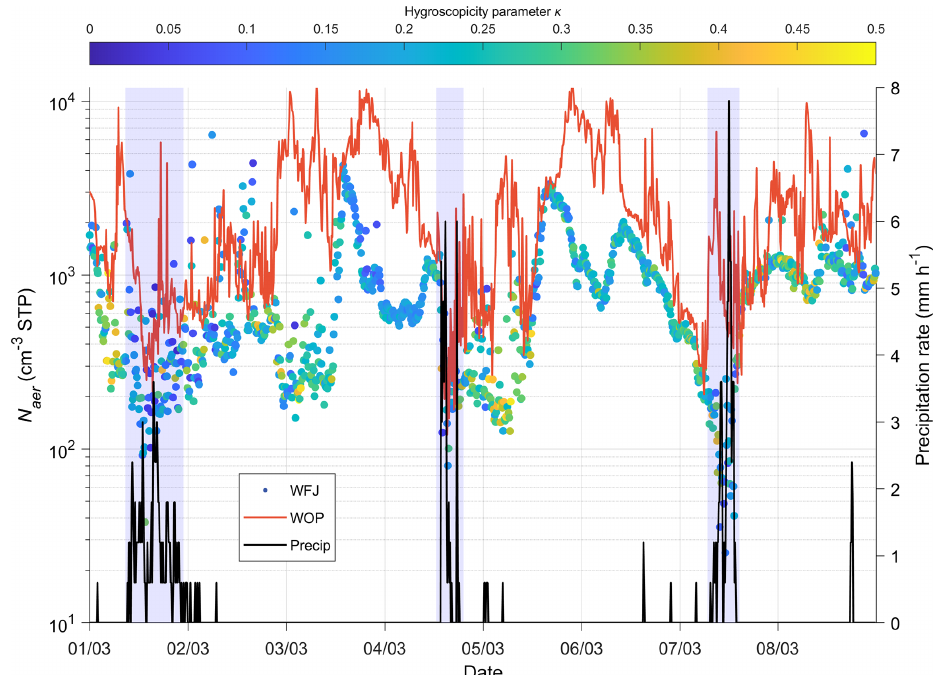
Figure 2. N aer (cm − 3 STP) at WOP (orange line) and at WFJ (circles colored by κ ). The black solid line represents the precipitation rate (mmh − 1 ) recorded from the MeteoSwiss observation station for each 10min interval at WFJ between 1 and 8 March 2019. The blue shaded areas represent the periods when precipitation recorded at the WFJ site is most intense.